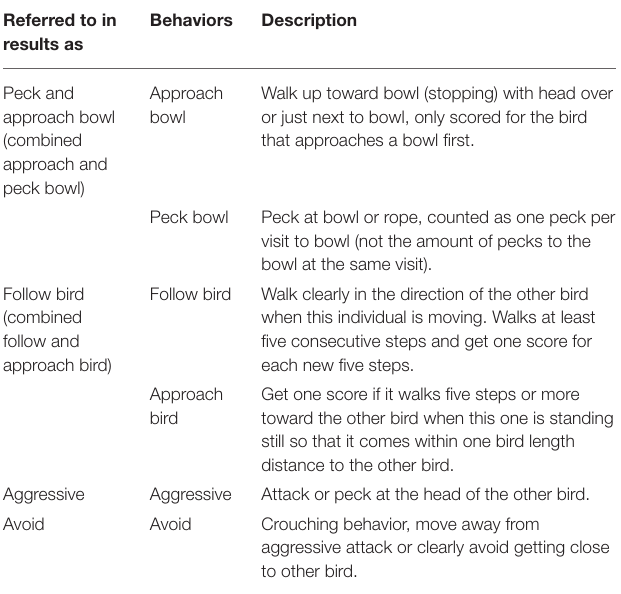
TABLE 2 | Behavior observations carried out during testing of the birds in the social feeding test. Referred to in Behaviors Description results as